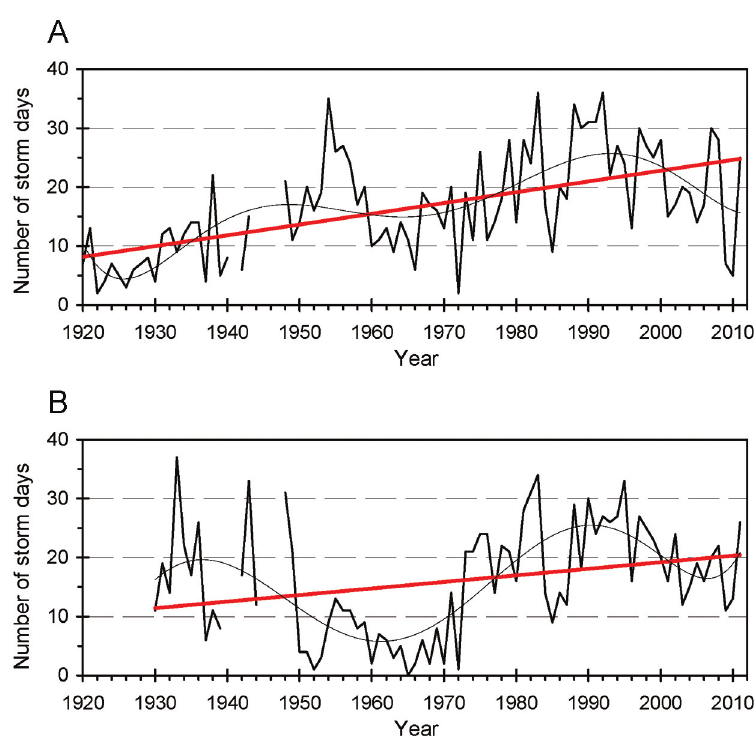
Fig. 2. Time series of the annual number of storm days recorded at Vilsandi ( A ) and Sõrve ( B ) with the linear trend and 5-order polynomial line to illustrate possible cycles and long-term tendencies (with some gaps in the